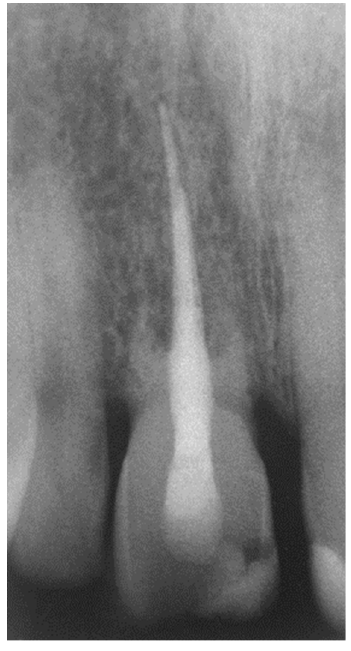
Figure 8. Rx at the 7-year recall visit.